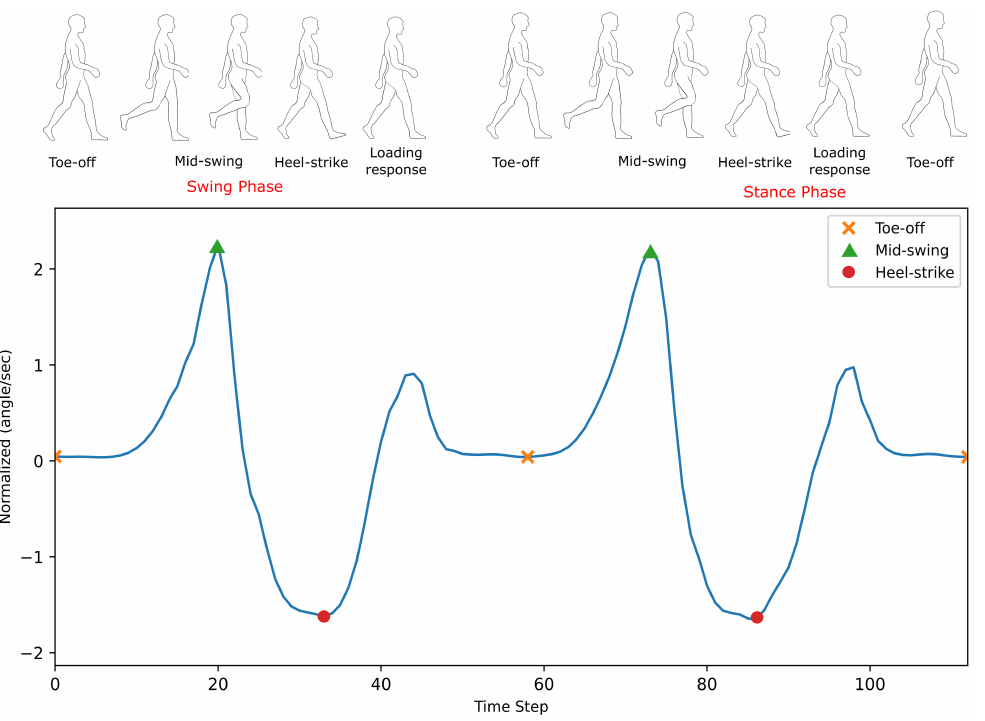
Figure 6. Gait Phase Segments (1 TS = 20